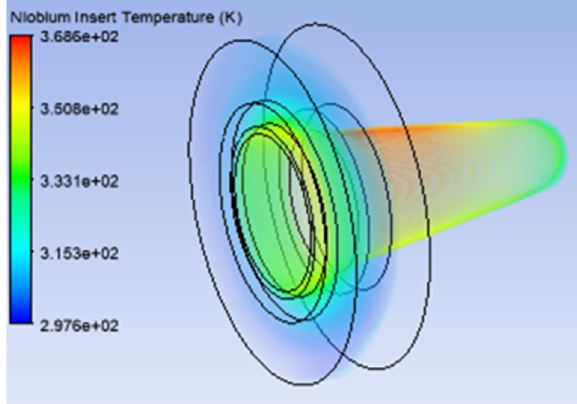
Figure 7. Temperature of the surface of the niobium insert in contact with the cooling water.